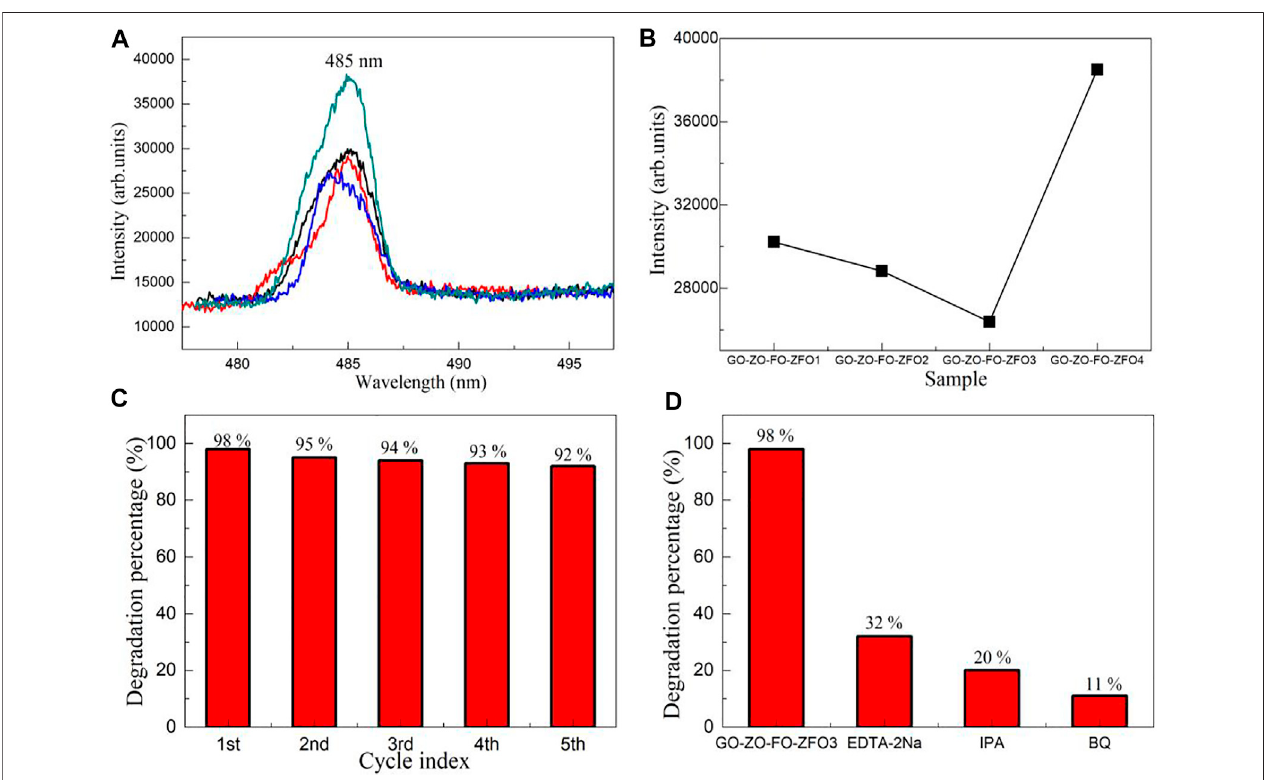
FIGURE 8 | (A) Emission spectra ( λ ex = 300 nm) of the GO/ZO/FO/ZFO photocatalyst. (B) Maximum emission intensity at 485 nm of the GO/ZO/FO/ZFO photocatalyst. The (C) stability and (D) trapping experiments of the GO/ZO/FO/ZFO3 photocatalyst.